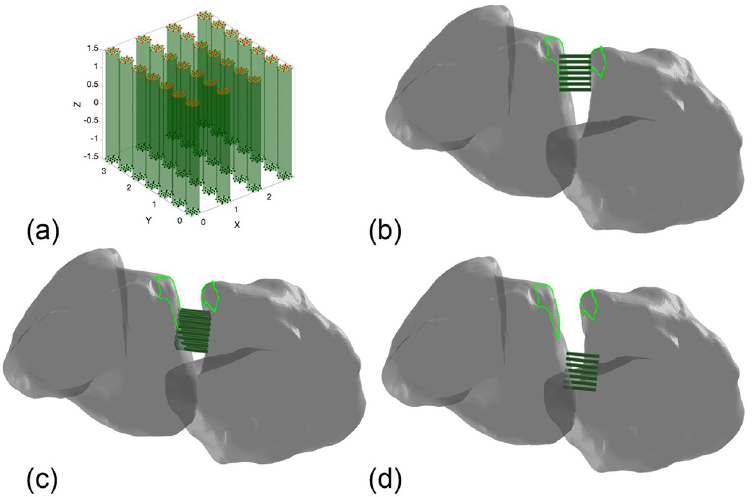
Fig 5. FEA models. (a) The 28 fibres represent the ligament-scaffold where red and black nodes are prescribed boundary conditions. Rigid bones demonstrate (b) distal, (c) intermediate and (d) proximal ligament-scaffold installation sites for